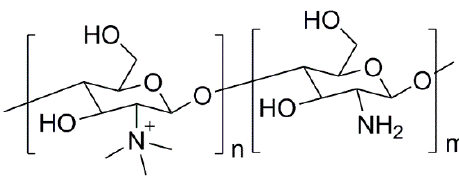
Figure 8. Chemical structure of poly(vinyl amine) with cationic, azetidinium and alkyl groups on the side chain [151].